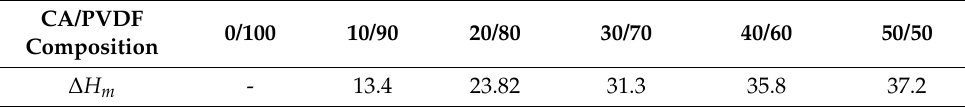
Table 3. The mixing enthalpy of prepared